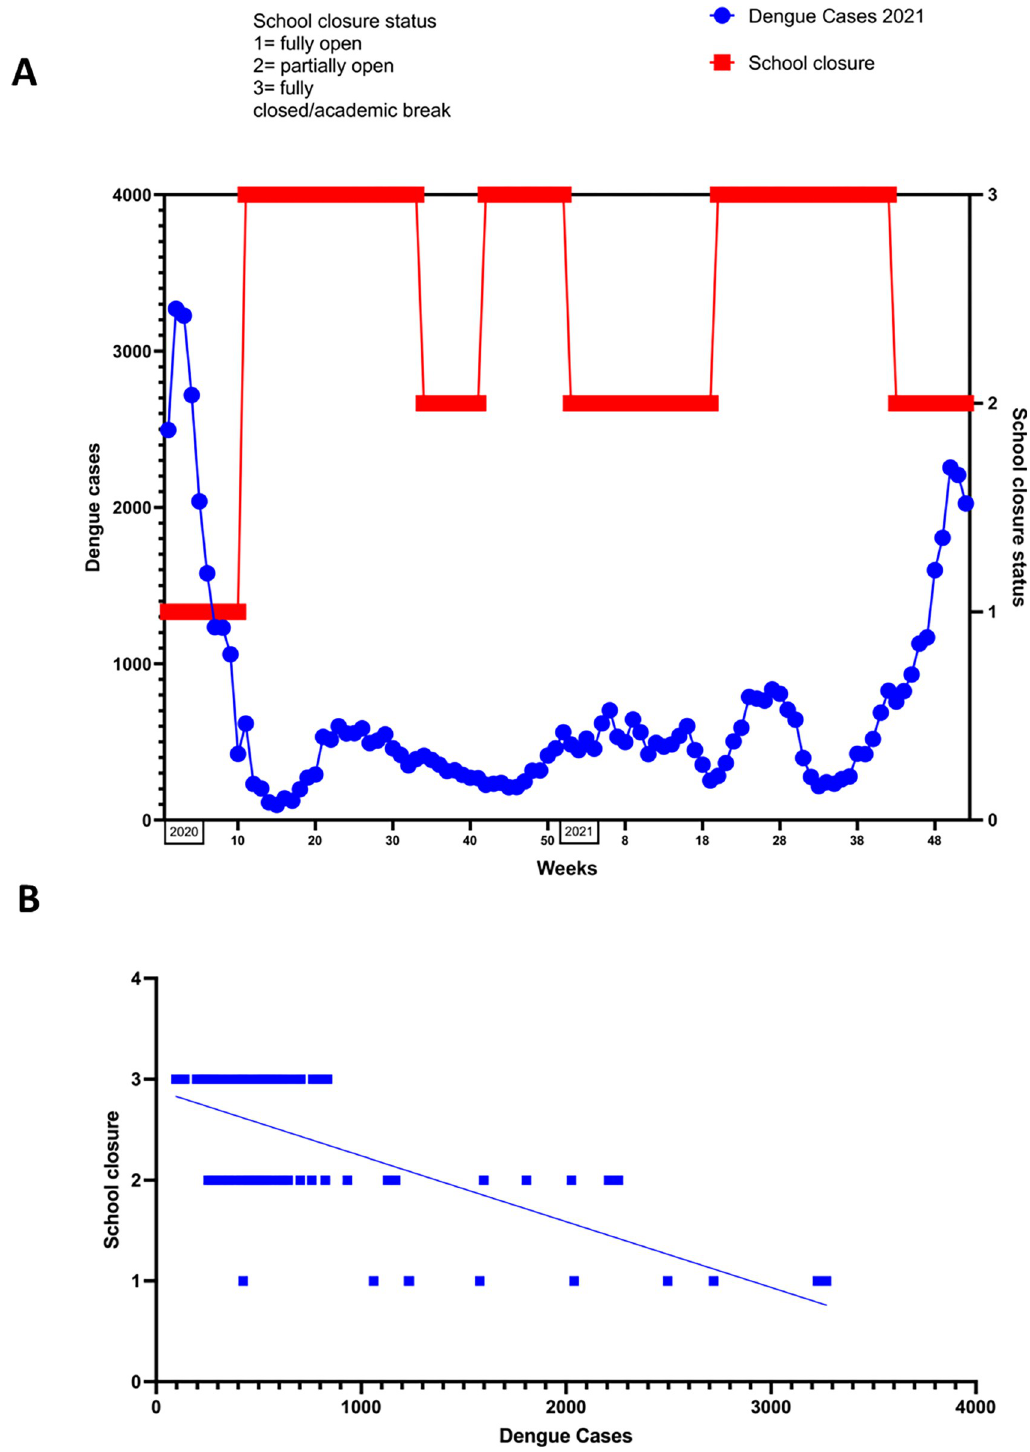
Fig 4. The relationship between number of dengue cases and periods of full and partial school closure in 2021(A) and the correlation between number of dengue cases and periods of full and partial school closure (B). The number of cases of dengue for 2021 were obtained from DenSys (2) and the SARS-CoV2 case numbers were obtained from Health Promotion Bureau (5). The data was plotted against school closure data for 2021 from UNESCO (7). School closure status was classified as 1 = fully open, 2 = partially open and 3 = fully closed/academic break. Spearman correlation was calculated (Spearman’s r = - 0.4732, p = < 0.0001). https://doi.org/10.1371/journal.pgph.0000399.g004 PLOS Global PublicHealth | https://doi.org/10.1371/journal.pgph.0000399 August 3,